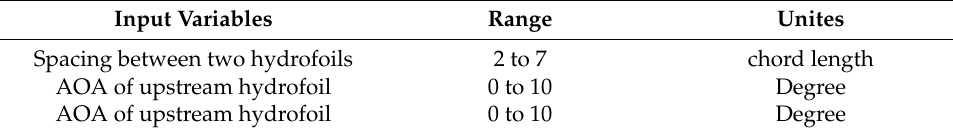
Figure 5. Schematic of the configuration of the tandem arranged hydrofoils. Table 5. Range of input